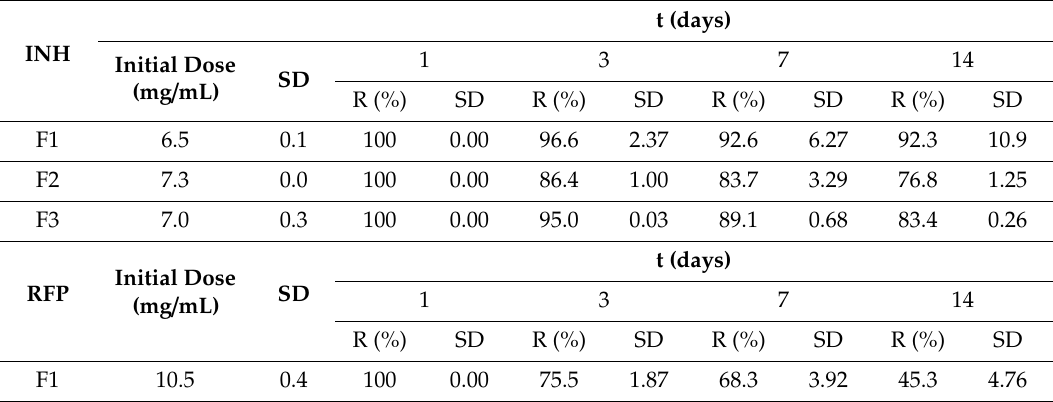
Table 4. Initial doses, pH, and percentages of INH and RFP remaining (R%) for 14 days storage of F1,